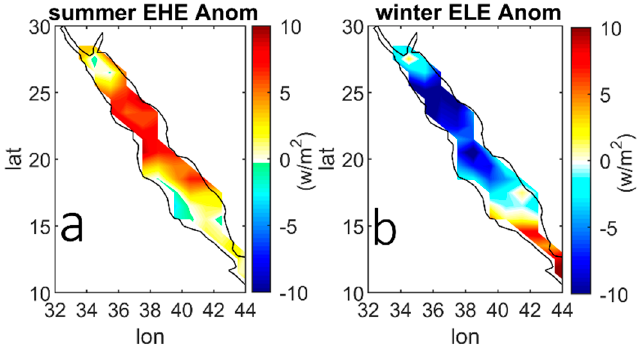
Figure 6. Composite anomalies of the net surface air–sea heat flux in w / m 2 for EHEs ( a ) and ELEs ( b ). Conversely, during the ELEs, the net surface air–sea heat flux is negative over the entire basin